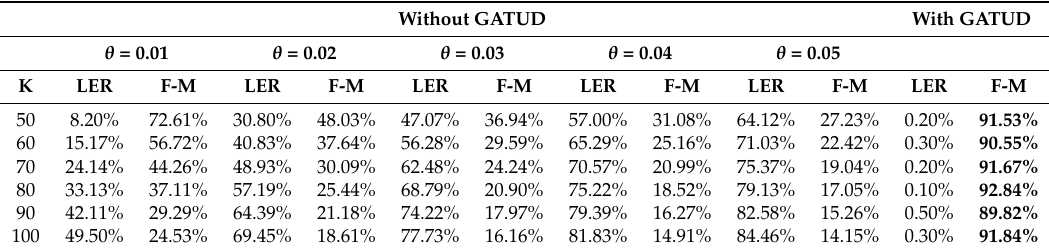
Table 23. The detection accuracy of k -means clustering algorithm with/without GATUD on MIRD. Without GATUD With GATUD θ =